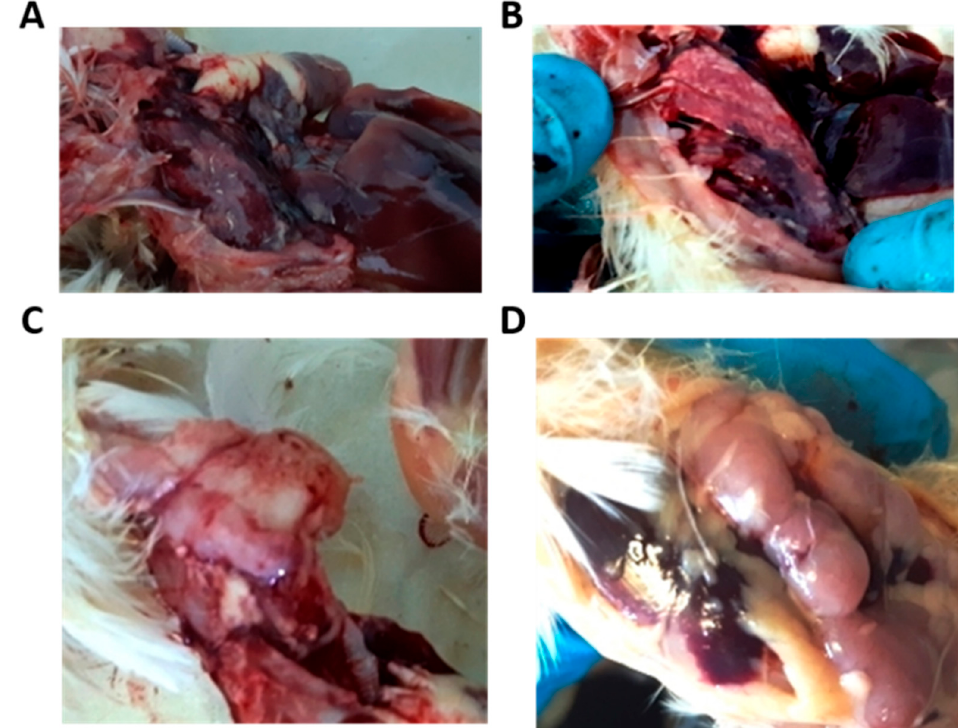
Figure 1. Macroscopic observations in lungs and thymus of control and experimental groups. Pneumonia signs were observed in the control group lungs ( A ) and experimental group lungs ( B ). Thymus inflammation in the control group ( C ) and thymus without noticeable changes in the experimental group ( D